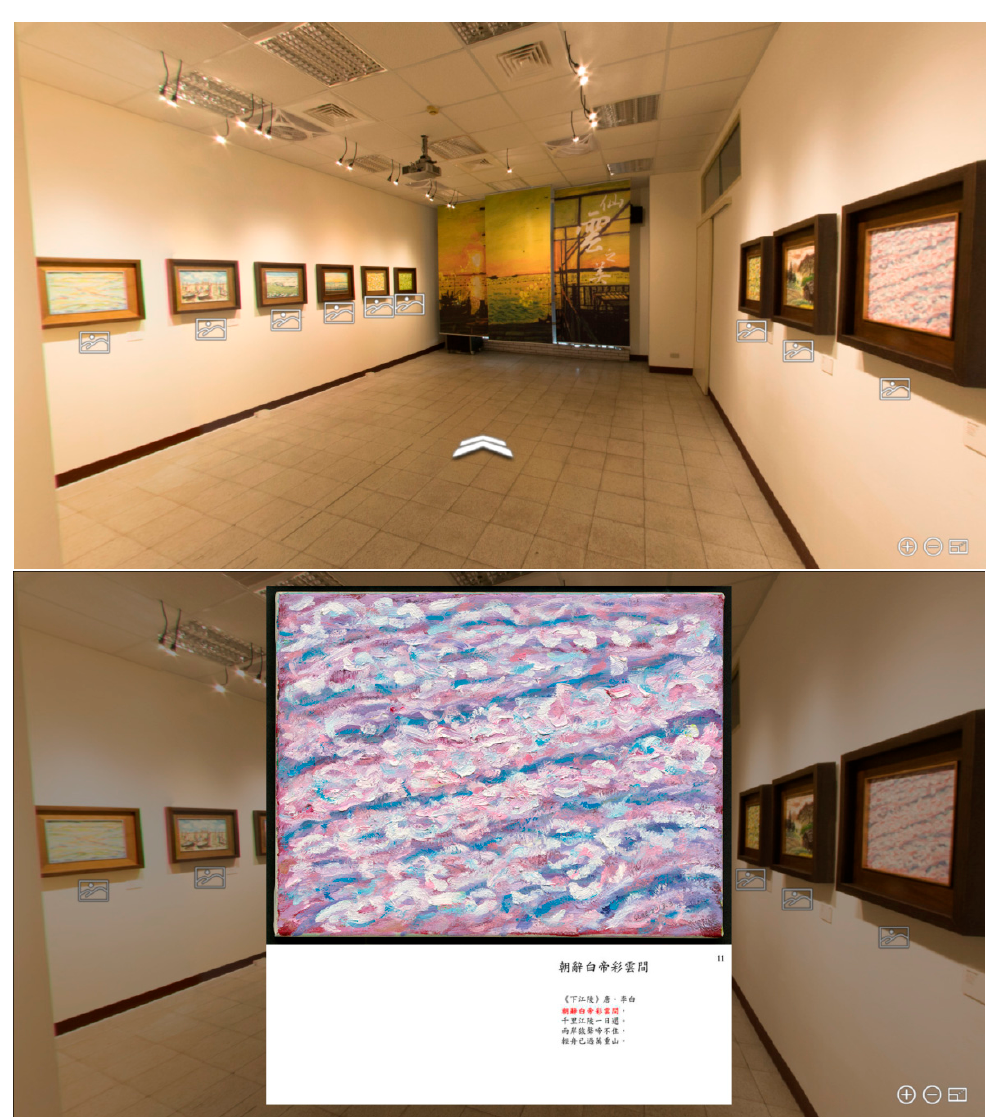
Figure 3. Painting exhibition with Desktop VR. The figure on the top is the whole space seen from the door and the figure on the bottom is the magnified image of one of the paintings.